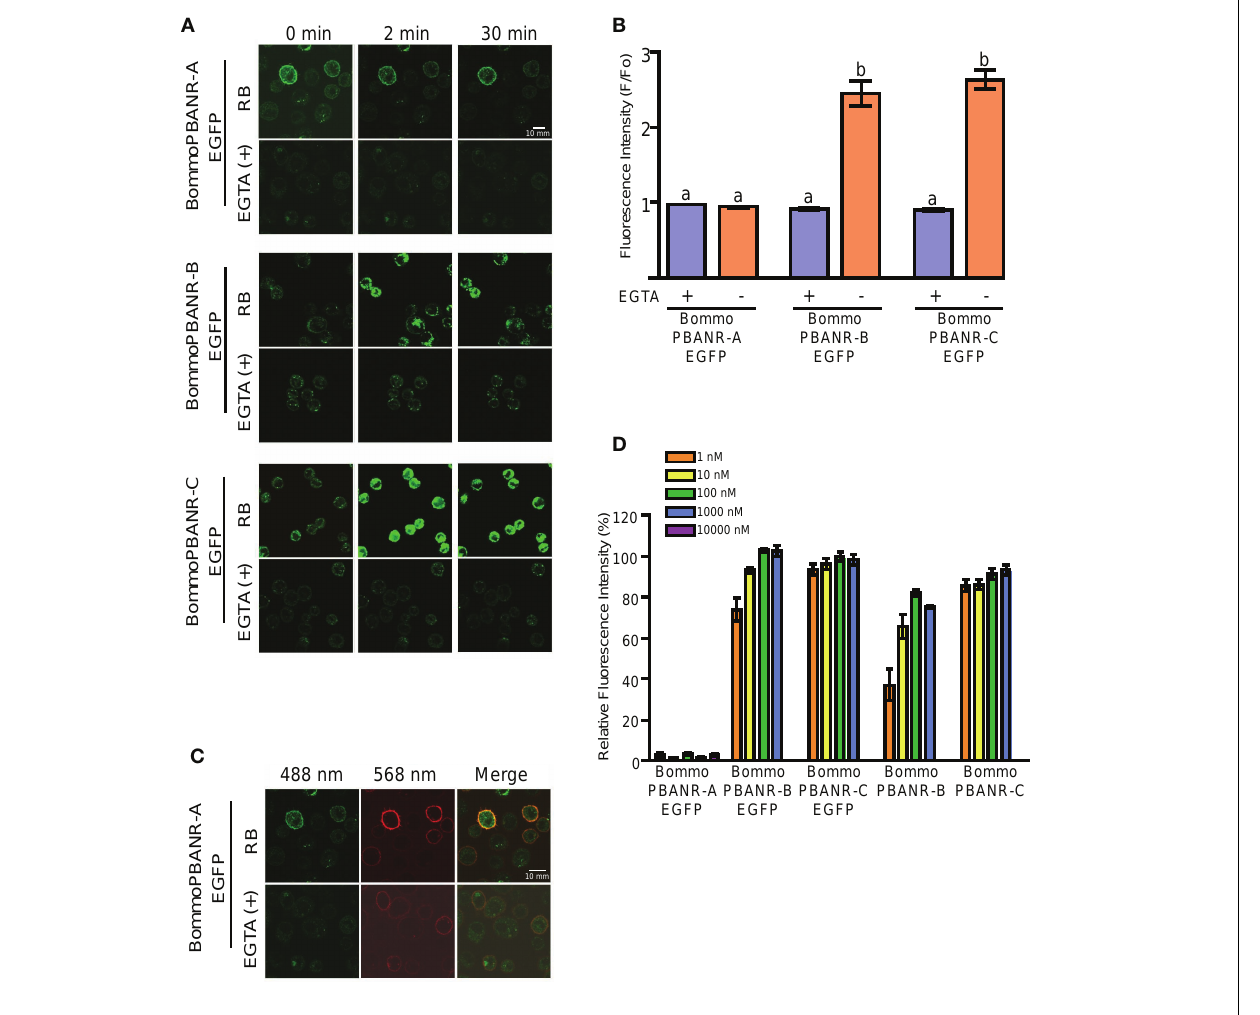
FIGURE 2 | Ligand-induced influx of extracellular Ca 2 + in stable Sf9 cell lines. (A) . RR-C10PBAN R2K (50nM) induced influx of extracellular Ca 2 + in Sf9 cell lines stably transformed with BommoPBANR–EGFP fluorescent chimeras. Cells were incubated in insect Ringer’s buffer (RB) or Ca 2 + -free RB buffer supplemented with 3mM EGTA [EGTA( + )]. Cells were imaged before and after (2 and 30min) addition of RR-C10PBAN R2K solution. (B) .The fluorescence intensity profile of BommoPBANR–EGFP Sf9 cell lines calculated as F/Fo (i.e., fluorescence prior to ligand application and 2min after ligand application) in response to RR-C10PBAN R2K (50nM). Bars represent mean values + SEM from independent cells ( n = > 8). (C) . Confocal imaging